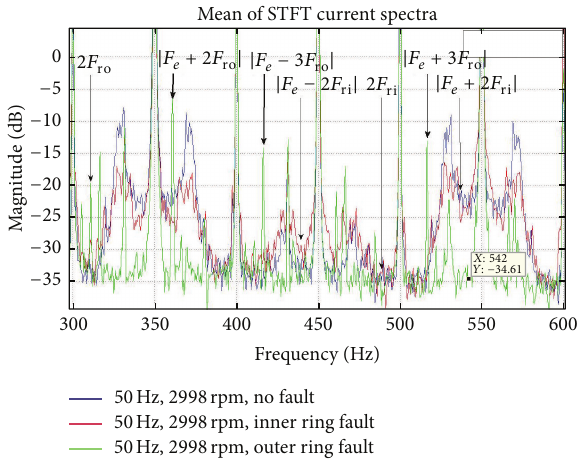
Figure 13: Nominal, inner defect, and outer defect spectra (300– 600 Hz) of 50 Hz motor input, free load condition, and current measurements.